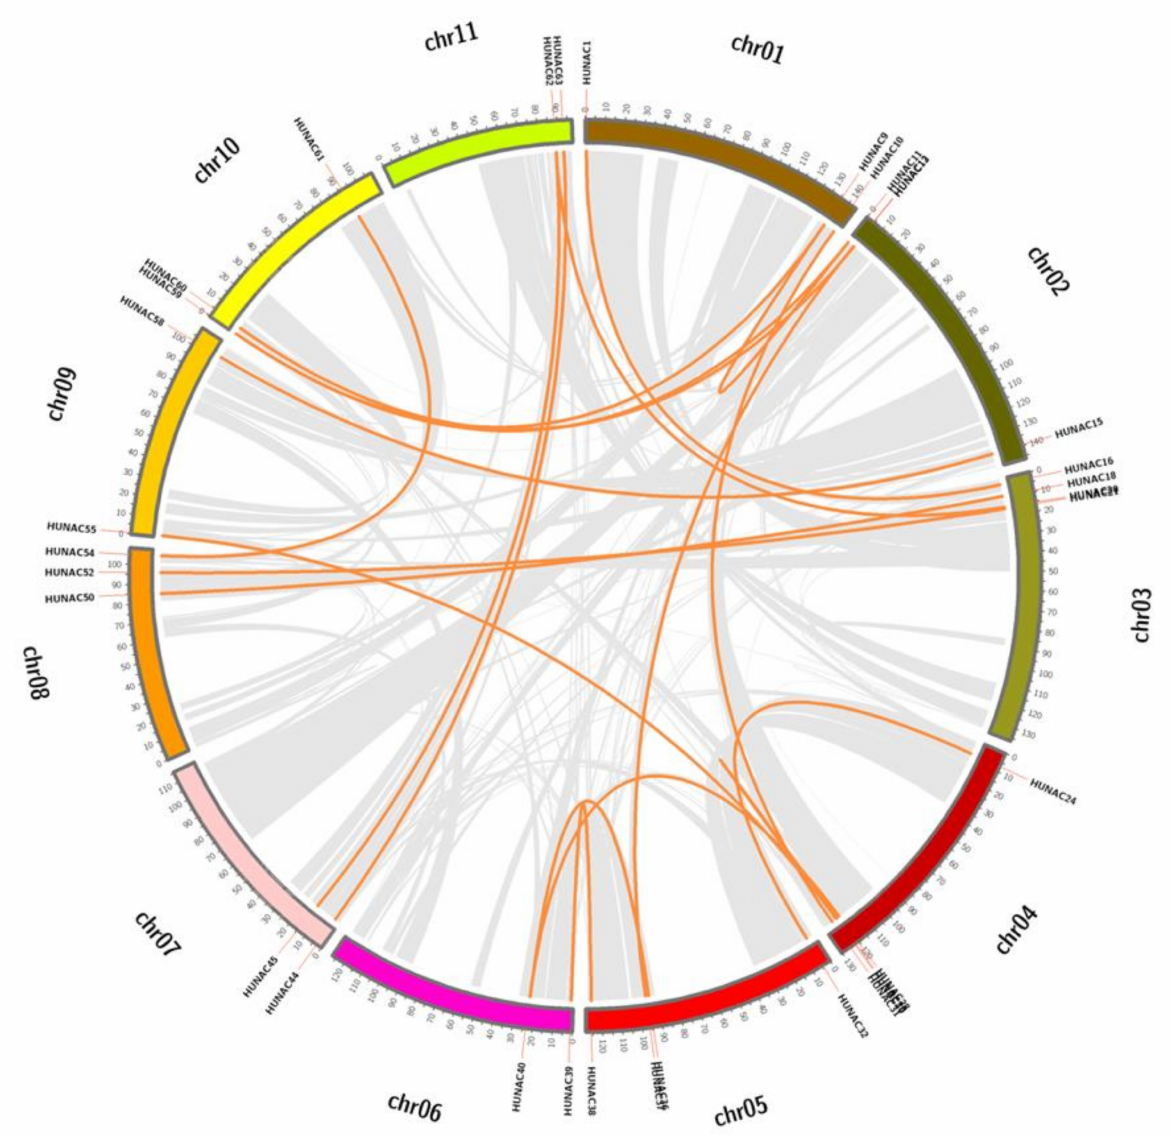
Figure 4. Schematic representations of interchromosomal relationships of the HuNAC genes. Gray lines represent all synteny blocks in the pitaya genome, and the orange lines indicate duplicated NAC gene pairs. The chromosome number is indicated at the top of each